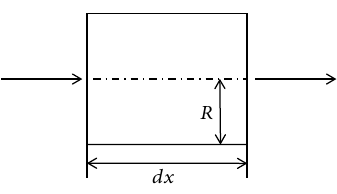
Figure 1: Flow unit of the capillary